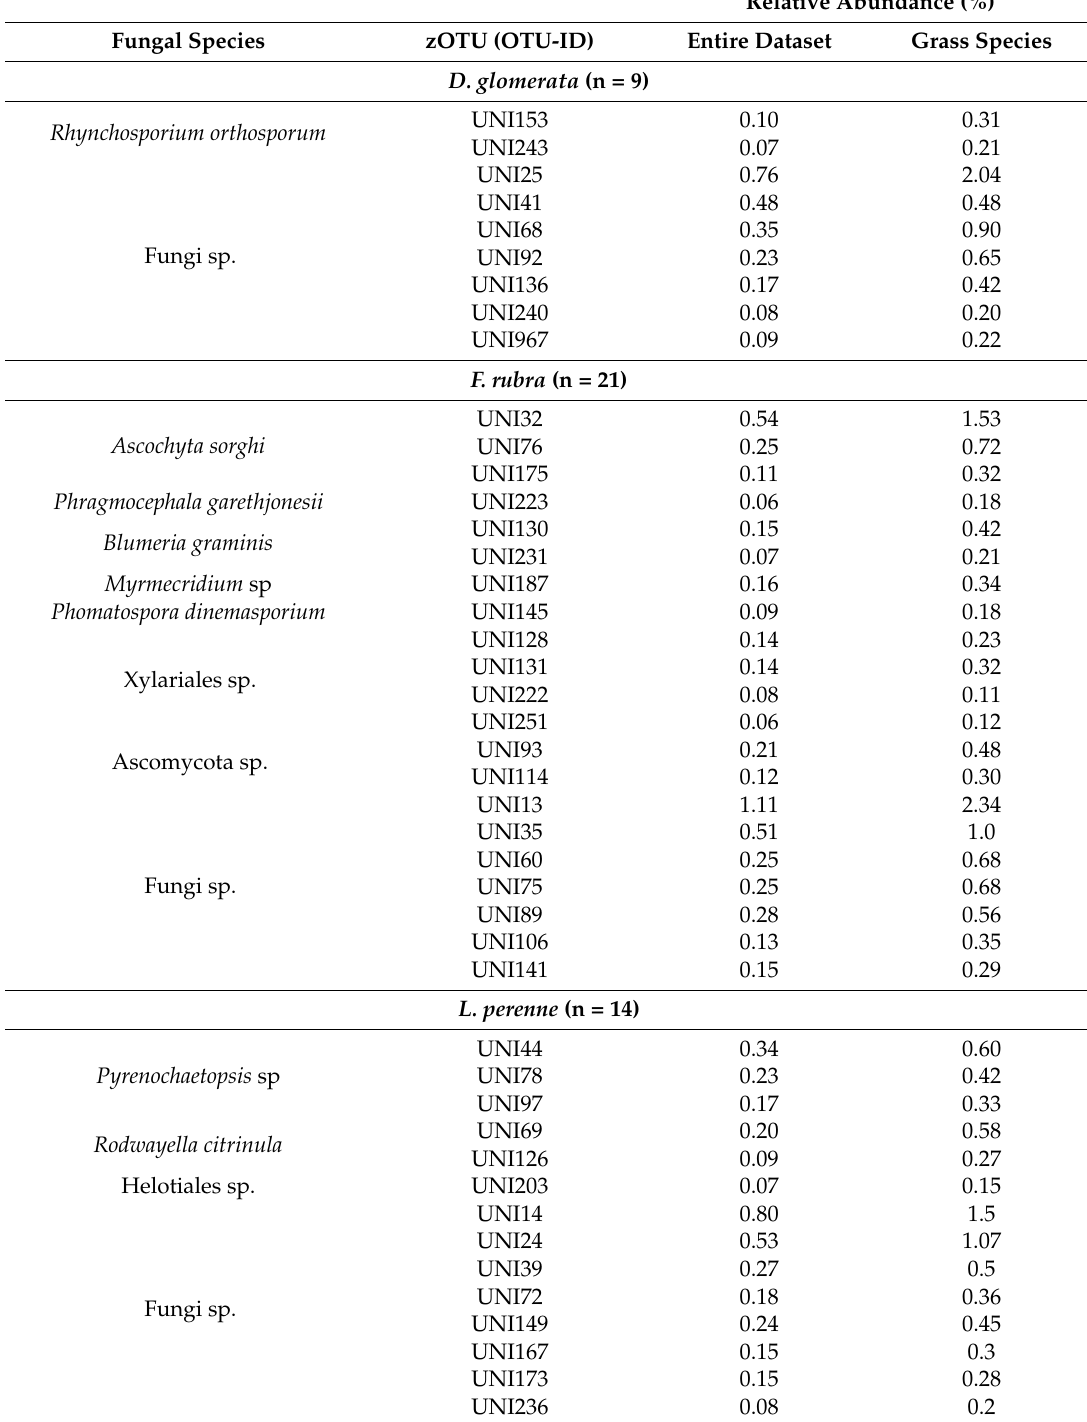
Table 3. Significantly associated fungal zOTUs with each grass species. The name of the zOTUs refers to the OTU-ID (see Table S2). The relative abundance of each zOTU in the entire dataset (2010 and 2011) as well as for their respective host grass species are